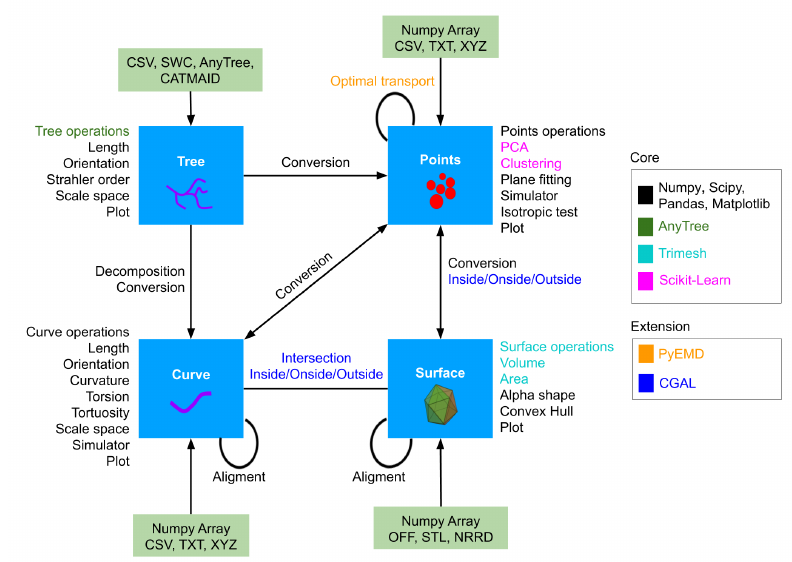
Figure 1. GeNePy3D architecture. The library is structured around four main classes for four principal geometrical objects, and propose various functions acting on them or converting between them, either implemented anew or linking to recognized